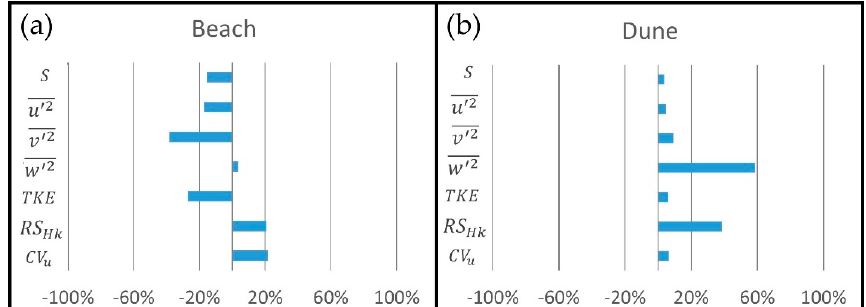
Figure 15. Average normalized difference in flow quantities (calculated as: {(((T1 0.5 − T1 1.5 ) − (T2 0.5 − T2 1.5 ))/T2B 1.5 )} at height (0.5 m and 1.5 m) between T1 and T2 at the beach ( a ) and dune ( b ) using the